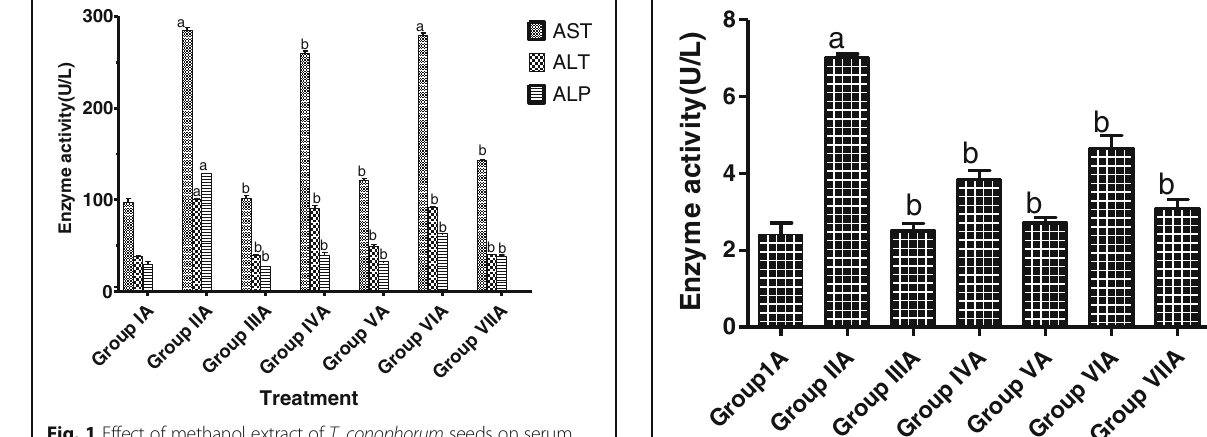
Fig. 1 Effect of methanol extract of T. conophorum seeds on serum Aspartate aminotransferase, Alanine aminotransferase and Alkaline phosphatase activities in CCl 4 induced hepatotoxicity in rats after 24 h of intoxication. Values are Mean±SEM, n =5 rats in each group. p < 0.05, a as compared with the normal control group; b as compared with the CCl 4 only (group IIA). AST- Aspartate aminotransferase; ALT- Alanine aminotransferase; ALP- Alkaline phosphatase; CCl 4 - Carbon tetrachloride. Group IA (control) received distilled water and olive oil (i.p), group IIA rats were intoxicated with CCl 4 in olive oil (600 mg/kg, i.p.) only on the 8th day, while groups IIIA, IVA and VA were given 100 mg/kg of silymarin, 250 mg/kg and 500 mg/kg of methanol extract respectively for 7 days, thereafter intoxicated with CCl 4 on the 8th day. Groups VIA and VIIA were intoxicated with CCl 4 on the 8th day and administered 250 mg/kg and 500 mg/kg of methanol extract of T. conophorum seeds at 1 h, 6 h, 12 h, 18 h and 24 h. Fasting blood samples were collected after the last administration of the extract at 24 h of intoxication with CCl 4